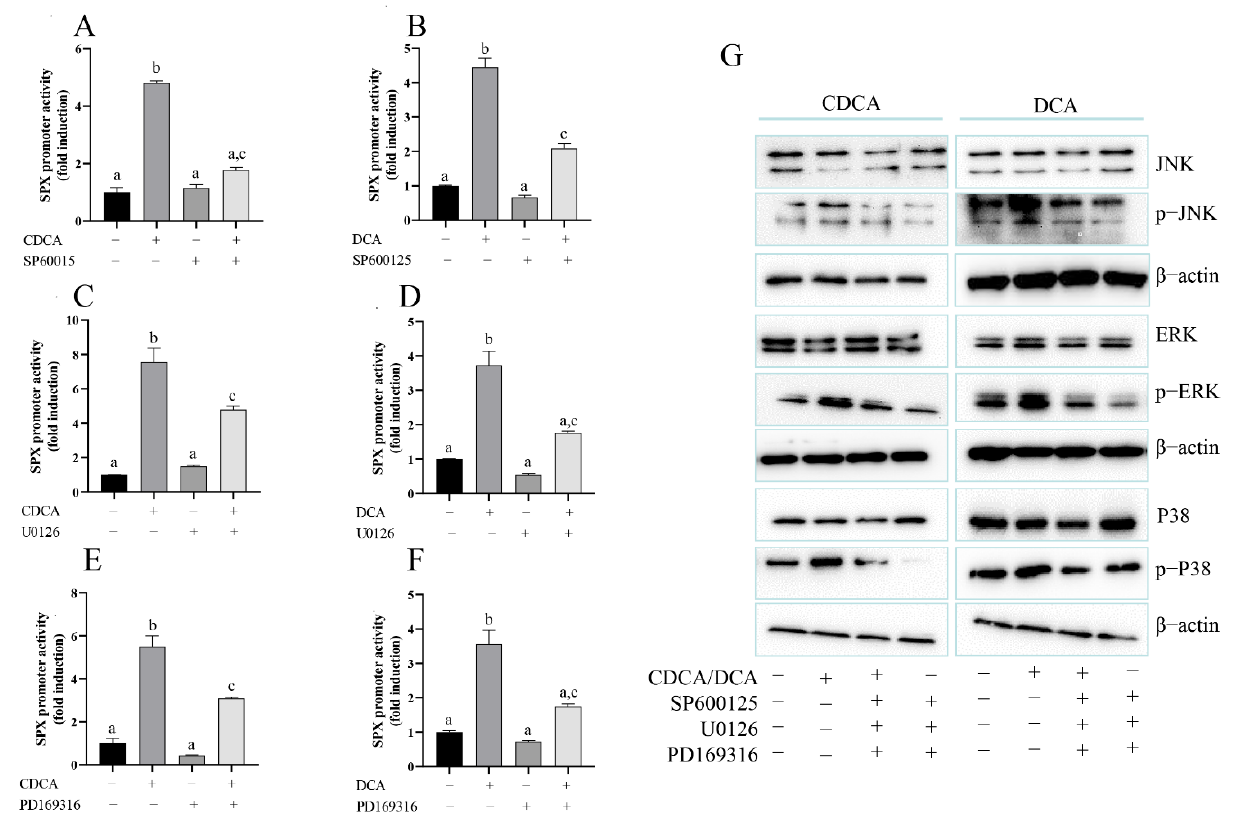
Figure 5. The role of MAPK pathway in bile acid-promoted SPX promoter activity. ( A ) SPX promotor activity was measured with CDCA treatment in the presence or absence of SP600125. ( B ) SPX promotor activity was measured with DCA treatment in the presence or absence of SP600125. ( C ) SPX promotor activity was measured with CDCA treatment in the presence or absence of U0126. ( D ) SPX promotor activity was measured with DCA treatment in the presence or absence of U0126. ( E ) SPX promotor activity was measured with CDCA treatment in the presence or absence of